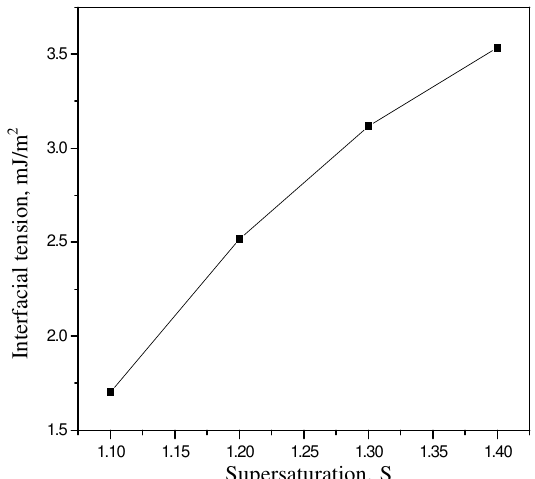
Figure 4. Linear relationships between interfacial tension and supersaturation.